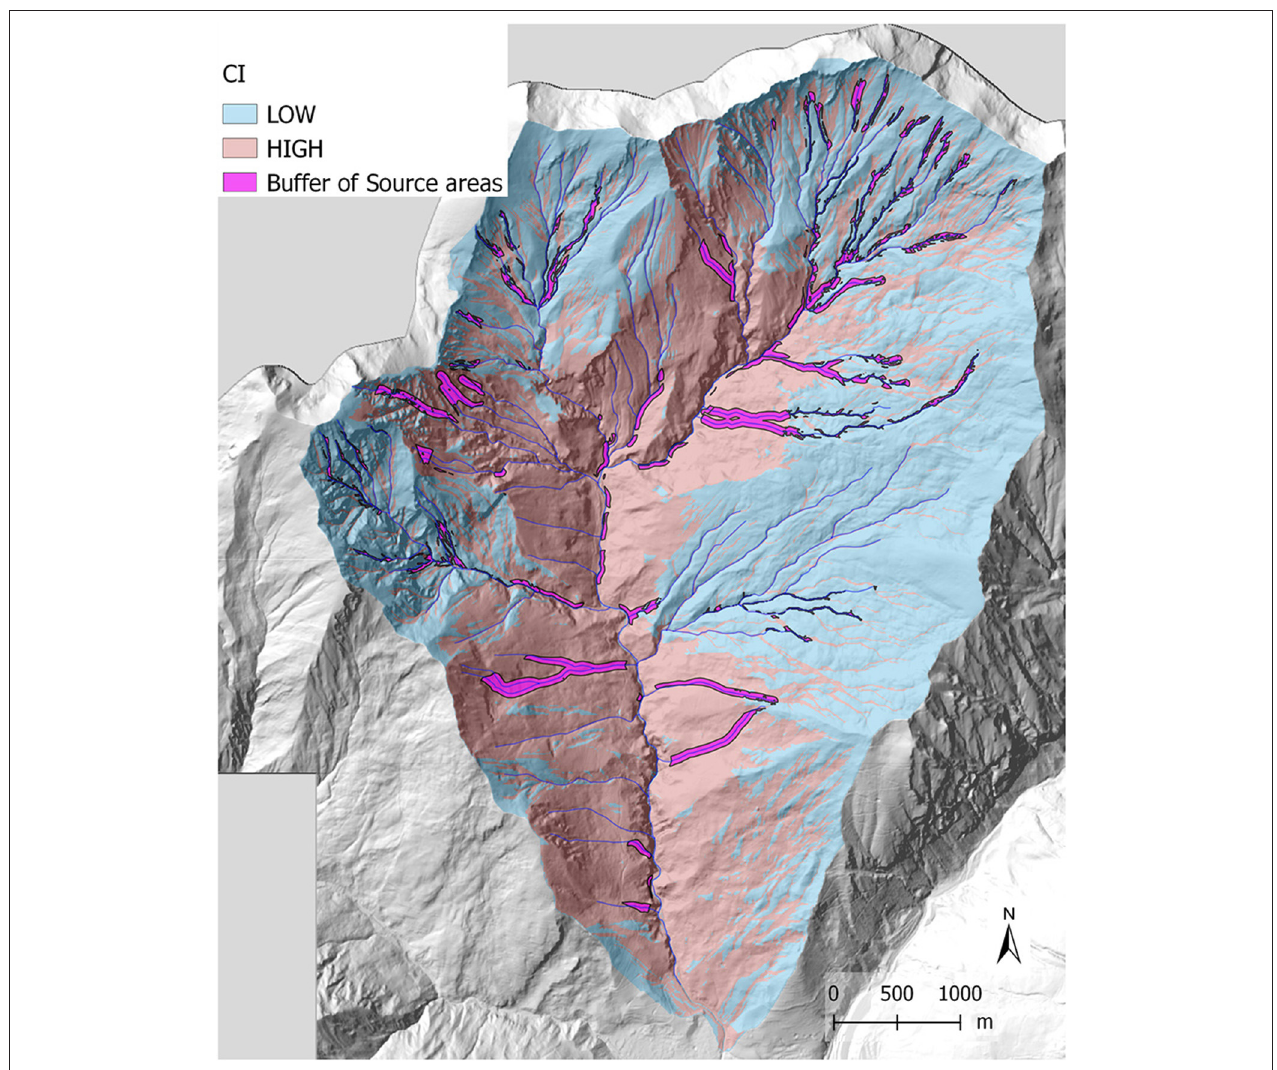
FIGURE 9 | Sediment source areas resulting from intersection between source deposits and a 50m buffer of the channel